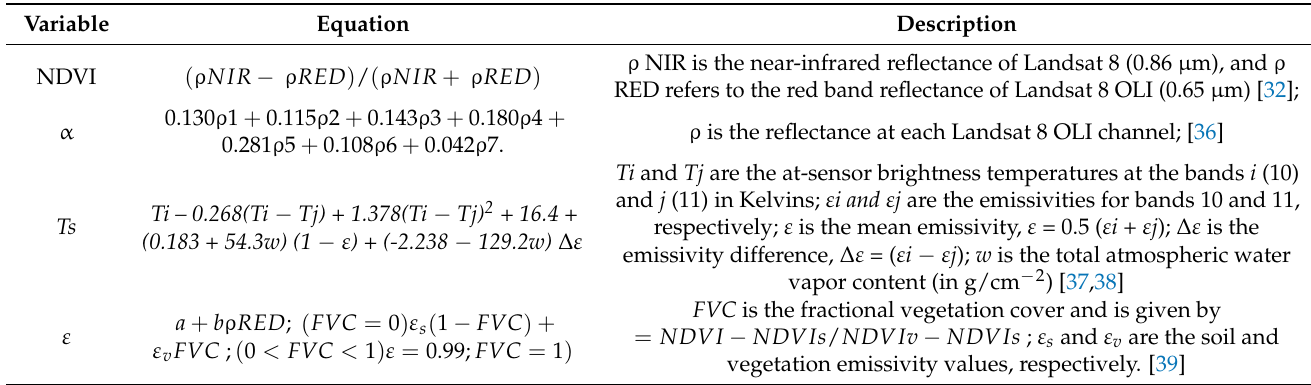
Table 2. Equations applied to Landsat 8